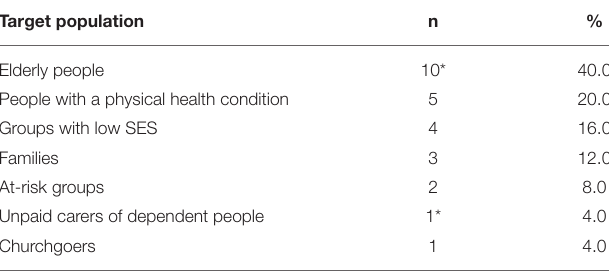
TABLE 4 | Target population of the programs reviewed ( n =